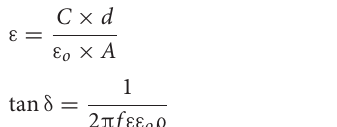
FIGURE 3 | XRD patterns of green-synthesized IONPs synthesized by using spinach and extracts: (A) PJ, (B) WV, (C) PP, (D) BC, (E) AP, and (F) As